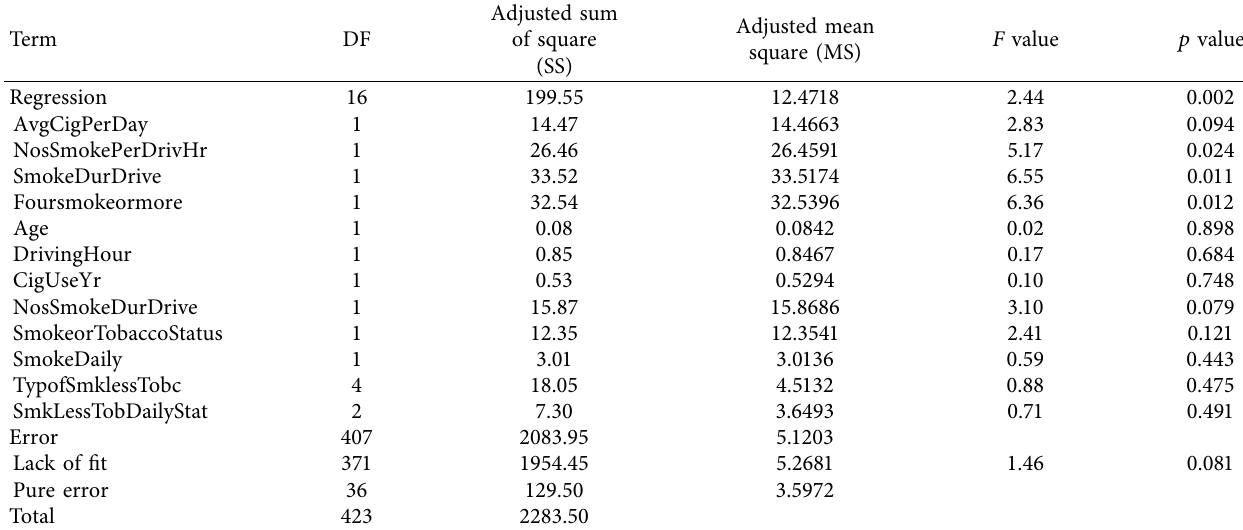
Table 3: Analysis of